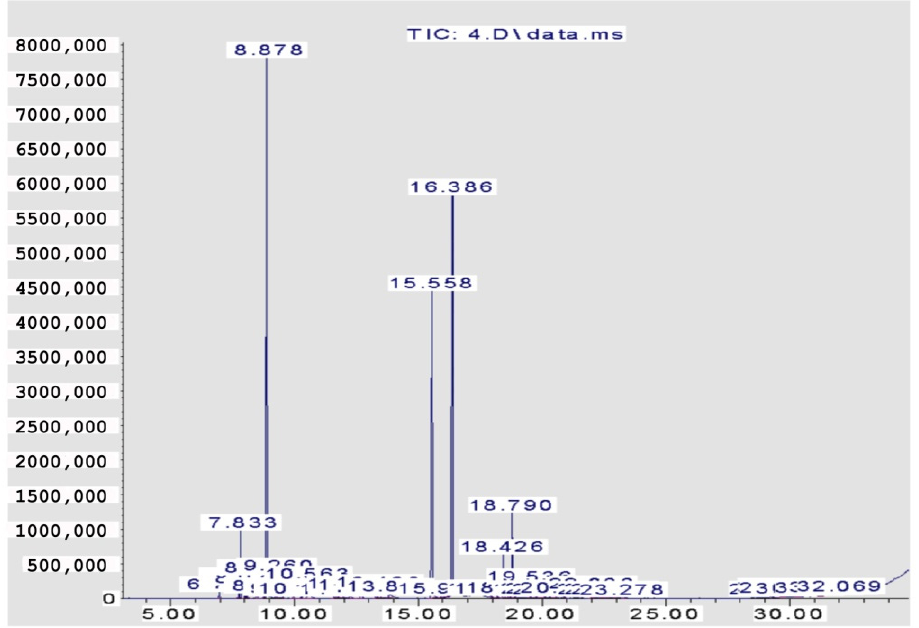
Figure 4. GC chromatogram of C. limon (HD). Twenty-six components were recognized from the oil of C. clementina leaves, represent- ing 68.54% of the total detected components. The major constituents of the oil were geranial Table 1. Chemical composition (%) of the essential oils isolated from Citrus species leaves using GC/MS analysis. (42.40%), followed by neral (26.79%) and limonene (14.48%). However, 89.82% C. sinensis oil was identified, where the major peaks were for neral (27.52%), linalool (25.83%), and geranial (23.44%). The peaks identified in C. limon represented 93.96%; linalool was the major peak (44.21%), followed by sabinene (14.22%), and ocimene (6.09%). The hydro distilled oil of C. limon contained geranial (30.08%), limonene (27.09%), and neral (22.87%) as the predominant compounds in the identified peaks